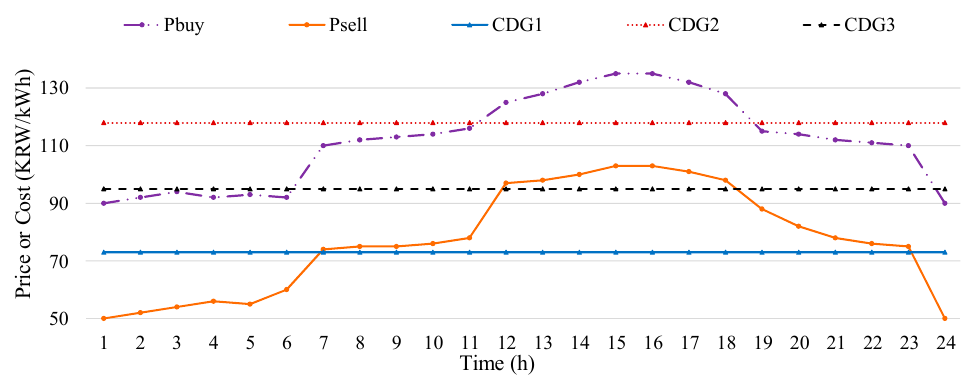
Figure 4. Real-time market price signals and generation cost of CDGs in each microgrid.